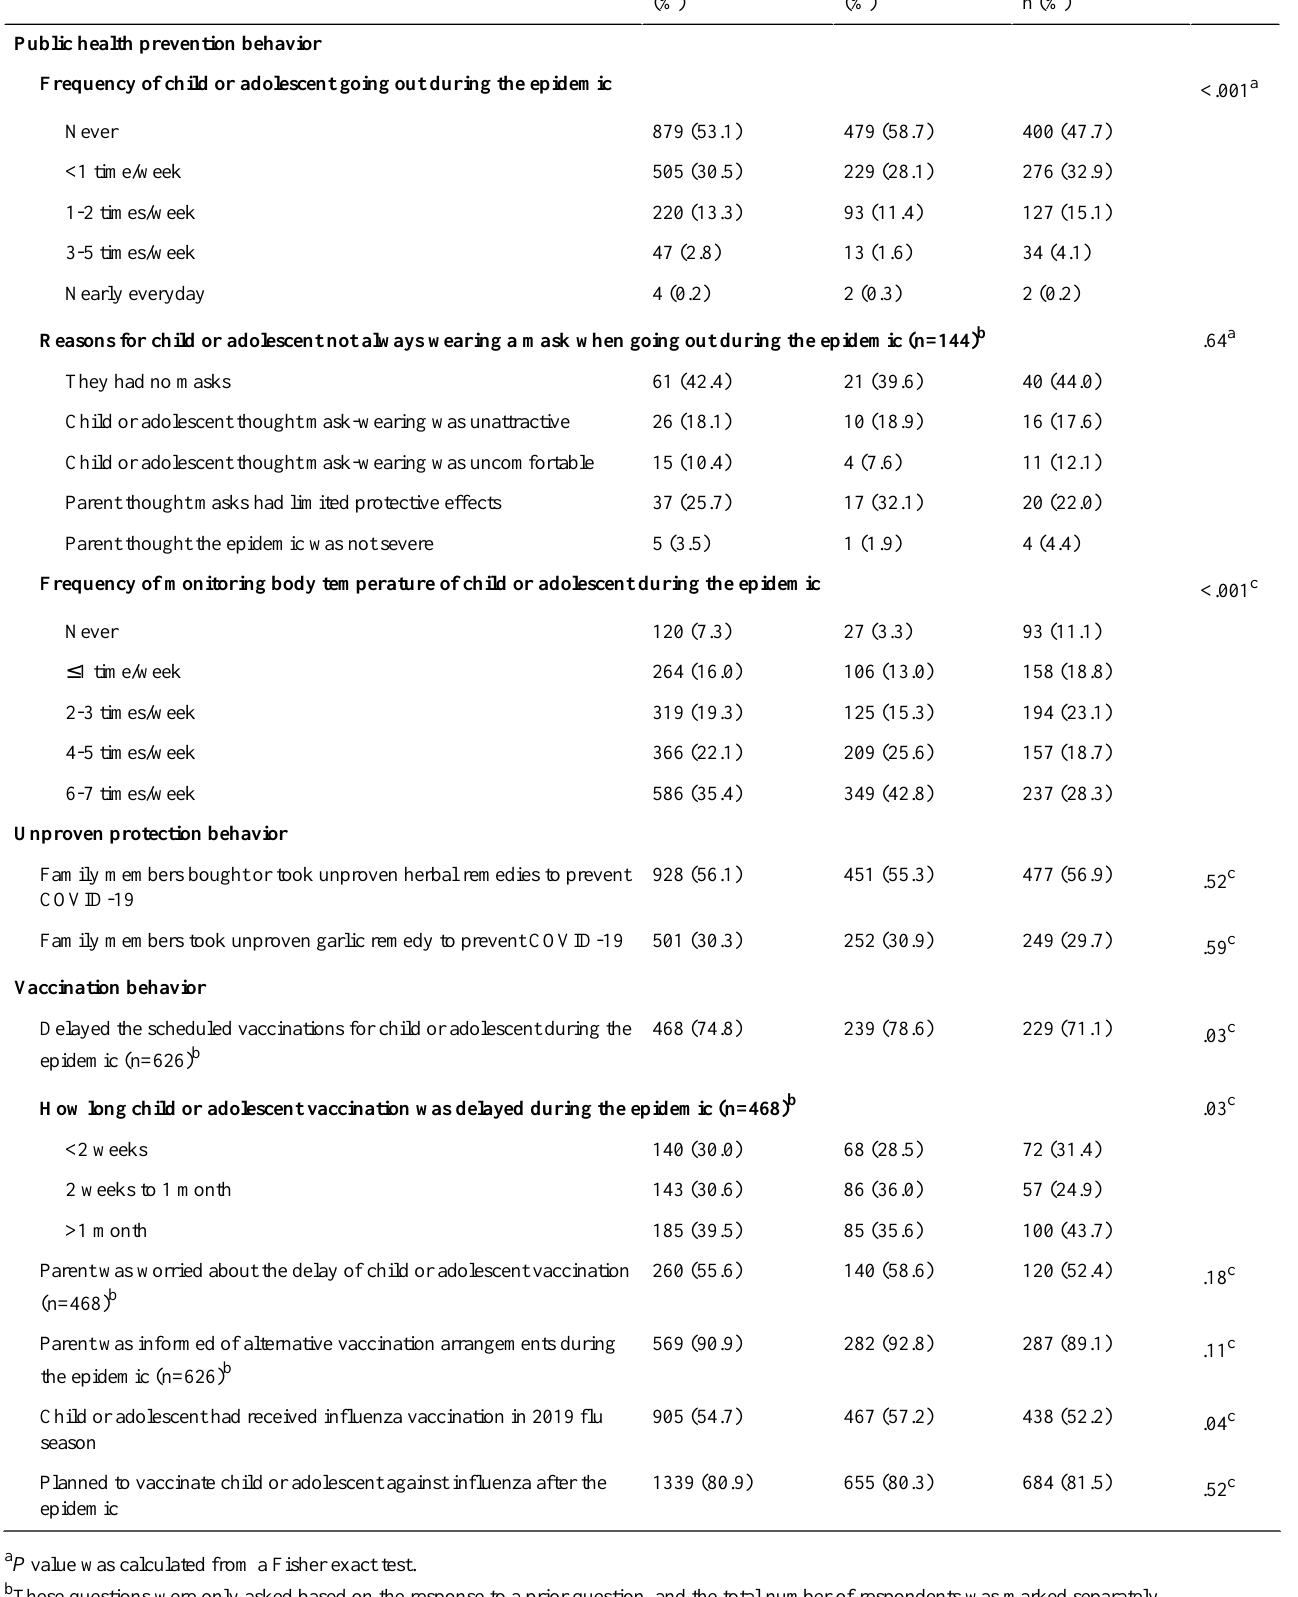
P valueShanghai